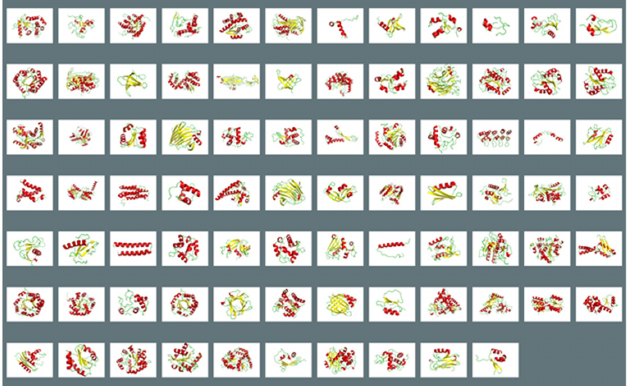
Fig 5. Protein structures in dTm prediction models. Alpha helixes are in red, beta sheets are in yellow, turns are in green. A diverse set of proteins with a mixture of different secondary structures were obtained.